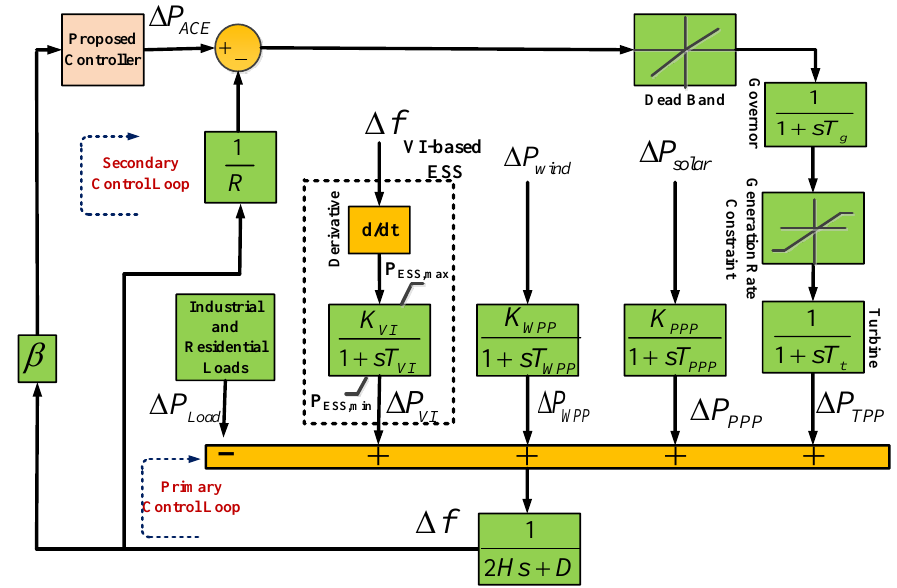
Figure 1. Schematic of the studied MG.